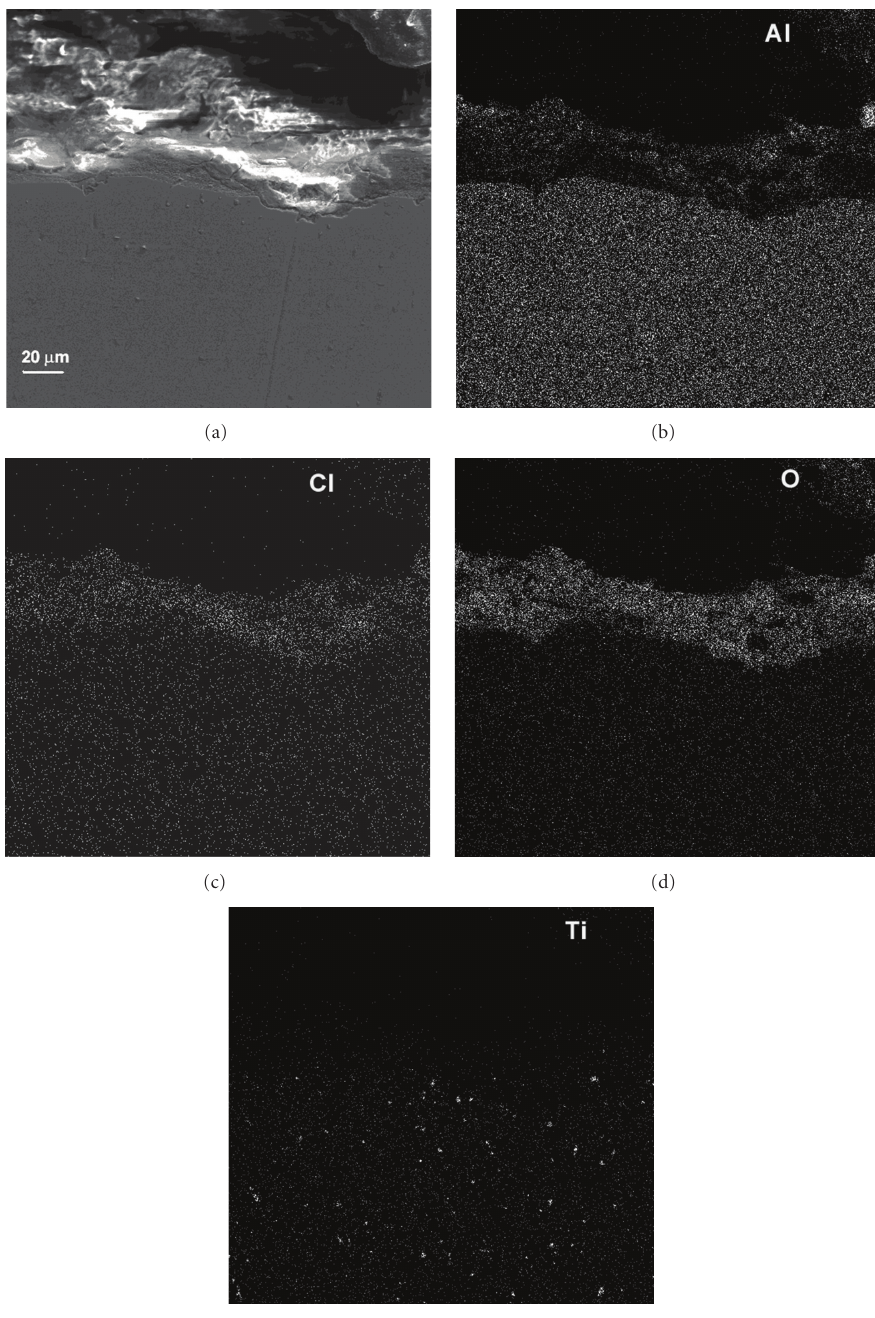
Figure 11: Microphotograph of Fe40Al + 2.5Ti corroded in the KCl + ZnCl 2 mixture at 670 ◦ C together with X-ray mappings of Al, Cl, O and